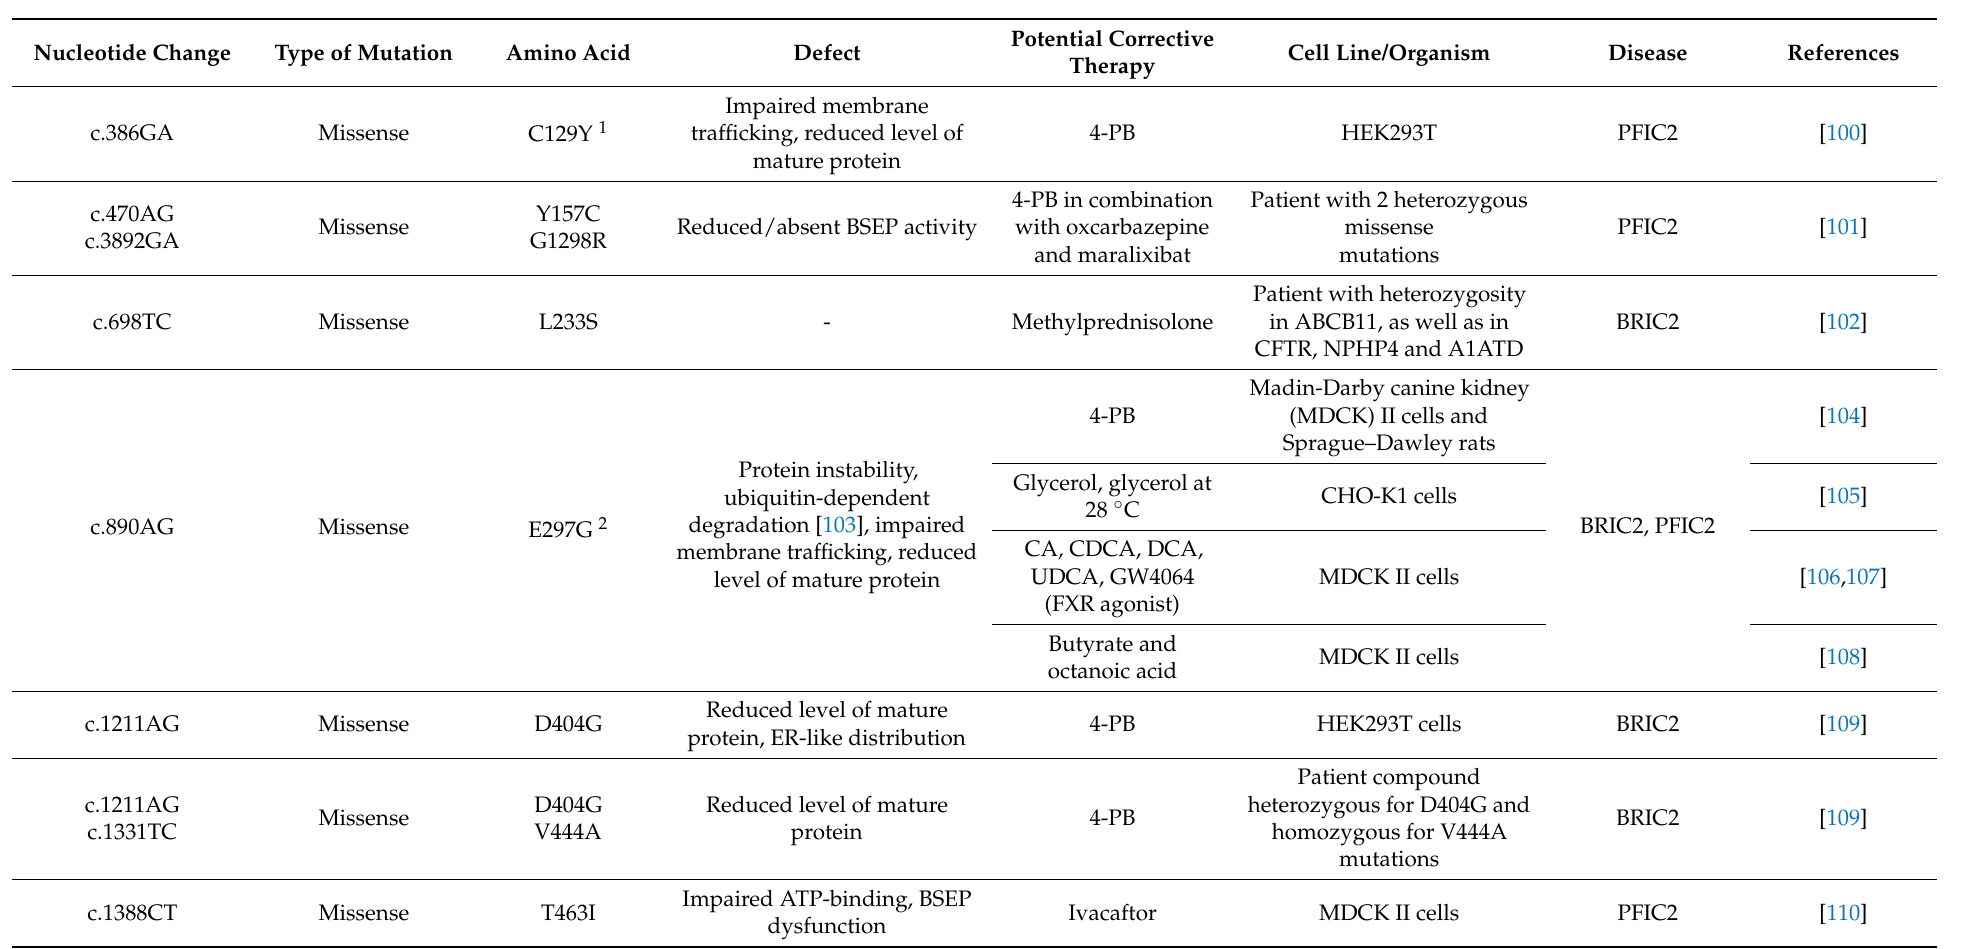
Table 1. Synopsis of a subset of disease-causing mutations, for which potential therapeutic interventions have been proposed. The defects, model systems and associated disease phenotypes are indicated. With the exception of the C129Y and G806D variants, the listed mutants represent a subset of a total of 192 disease-associated missense or nonsense mutations that have been identified to date [99]. PFIC2: progressive familial intrahepatic cholestasis type 2, BRIC2: benign recurrent intrahepatic cholestasis type 2,4-PB: 4-phenylbutyrate, CA: cholic acid, CDCA: chenodeoxycholic acid, DCA: deoxycholic acid, UDCA: ursodeoxycholic acid, FXR: farnesoid X